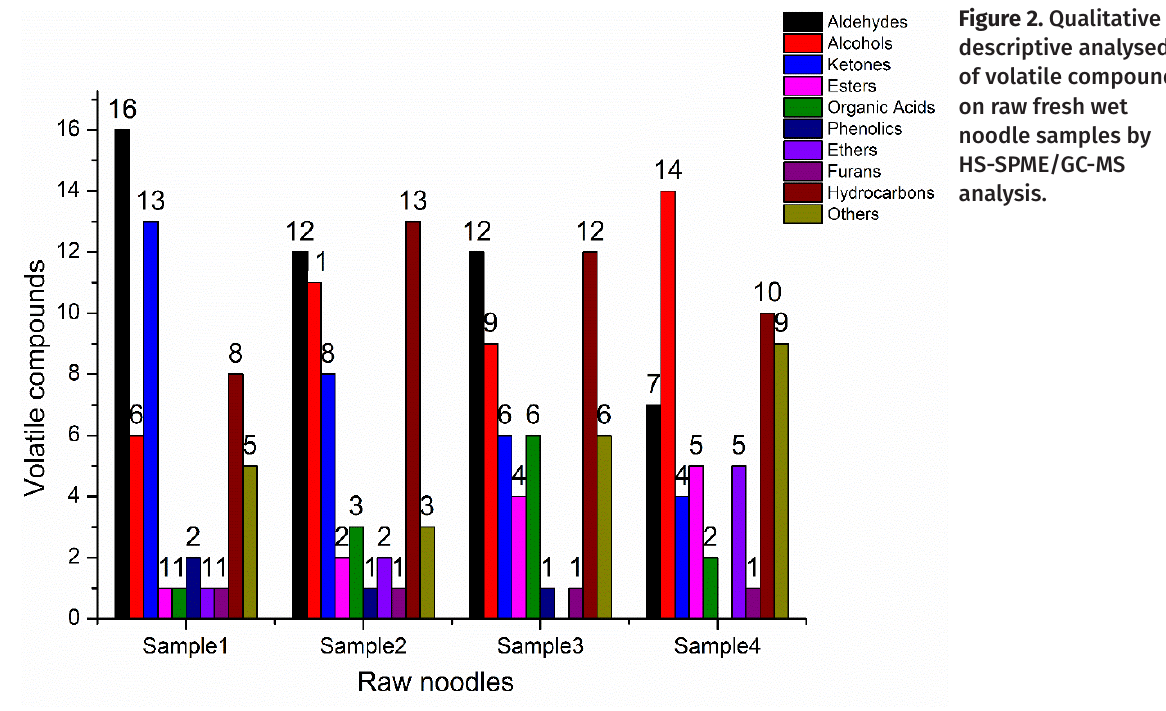
Figure 2. Qualitative descriptive analysed of volatile compounds on raw fresh wet noodle samples by HS-SPME/GC-MS